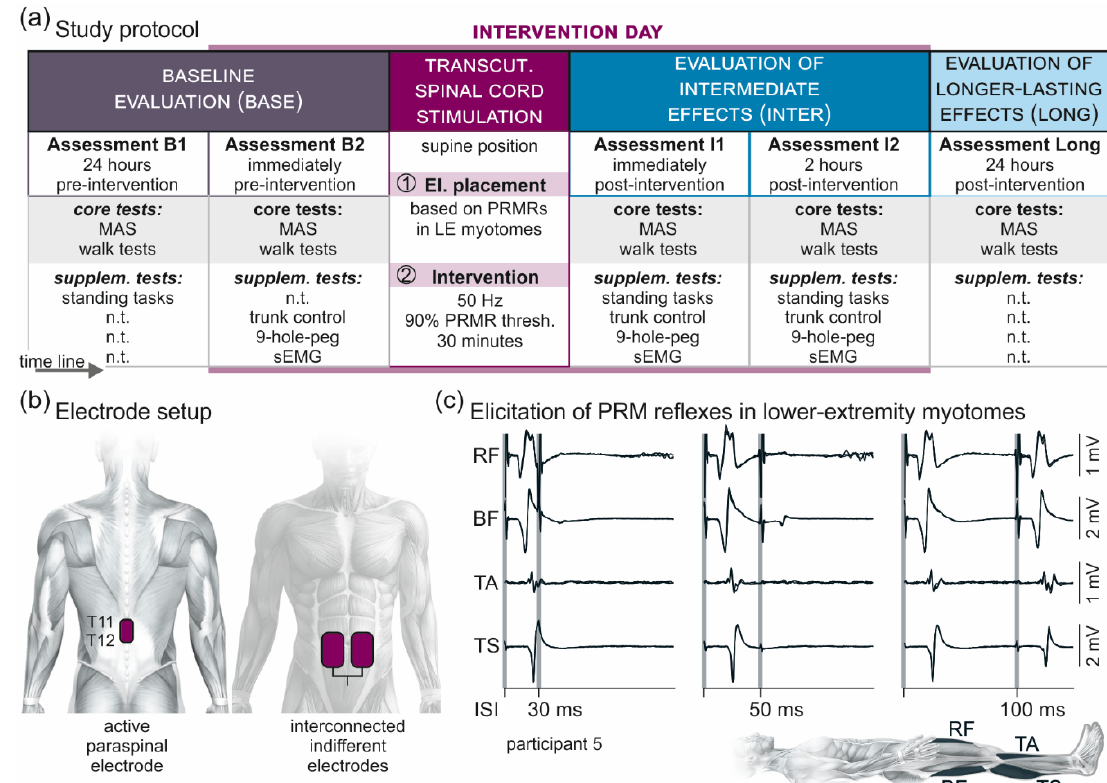
Figure 1. Overview of the methodology. ( a ) Study protocol comprising a baseline evaluation (Base) with two assessments, one conducted ~24 h (B1) and the other one immediately (B2) before a 30-min session of 50-Hz transcutaneous (transcut.) spinal cord stimulation; an evaluation of intermediate carry-over effects (Inter) with two assessments, one conducted immediately (I1) and the other one two hours (I2) post-intervention; and an evaluation of longer-lasting carry-over effects (Long) of the stimulation conducted ~24 h post-intervention. Each assessment included, as core tests, the clinical determination of lower-extremity muscle hypertonia based on the Modified Ashworth Scale (MAS) and, in the ambulatory participants, the timed 10-m walk test, the timed up-and-go test, and the 2-min walk test. Supplementary (supplem.) tests were conducted as indicated in B1 or B2 as well as in I1 and I2, and included standing tasks, the trunk control test, the timed nine-hole-peg test, and a surface-EMG (sEMG) based assessment of lower-extremity spasticity. Transcutaneous spinal cord stimulation was applied with the participants lying supine. First, effective electrode (el.) placement (cf. (b)) over the lumbosacral spinal cord was confirmed based on the elicitation of posterior root-muscle reflexes (PRMRs; cf. (c)) in lower-extremity myotomes. Second, for the intervention, transcutaneous spinal cord stimulation was applied for 30 min at 50 Hz and with an amplitude corresponding to 90% of the lowest PRMR threshold. n.t., not tested. ( b ) Electrode setup with the active paraspinal electrode placed longitudinally over the spine, covering T11 and T12 spinal processes, and a pair of interconnected indifferent electrodes on the lower abdomen. ( c ) Verification of effective stimulation site over the lumbosacral spinal cord by the elicitation of PRMRs in rectus femoris (RF), biceps femoris (BF), tibialis anterior (TA), and triceps surae (TS), which demonstrate a characteristic suppression at interstimulus-intervals (ISIs) of 30 ms and 50 ms when tested by paired pulses [39]. At interstimulus-intervals of 100 ms, the responses to the second stimulus had partially recovered. Shaded backgrounds mark times of stimulus application. Three repetitions each superimposed; participant